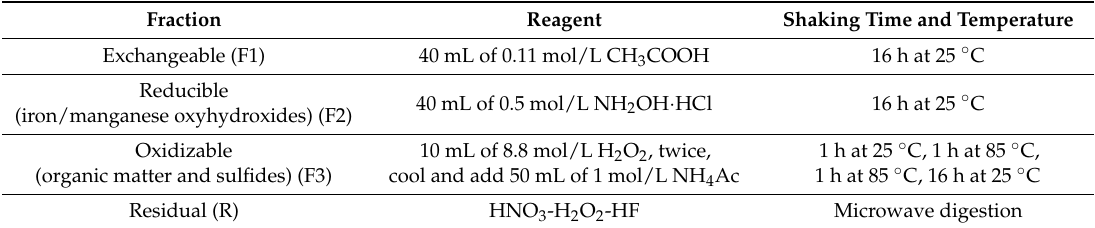
Table 2. Sequential extraction procedure for soil